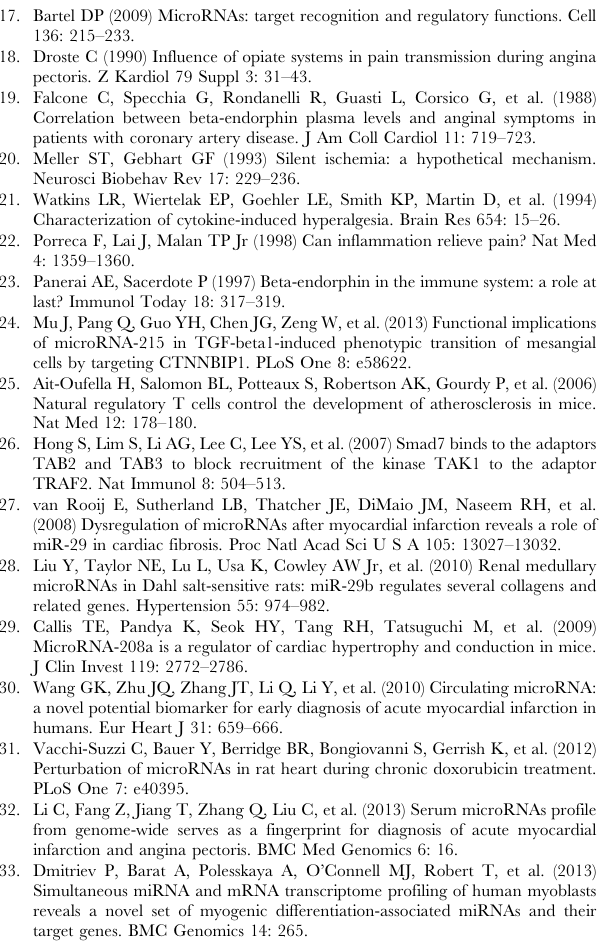
Table S1 Differentially-expressed miRNAs in ACAD serum samples compared to normal controls deter- mined by TaqMan Low Density Assay. Table S2 ROC curves and the corresponding AUCs of the five selected miRNAs for all the ACAD patients and controls in training set and validation set. Table S3 ROC curves and the corresponding AUCs of different serum-miRNA panels for all the ACAD patients and controls in training set and validation